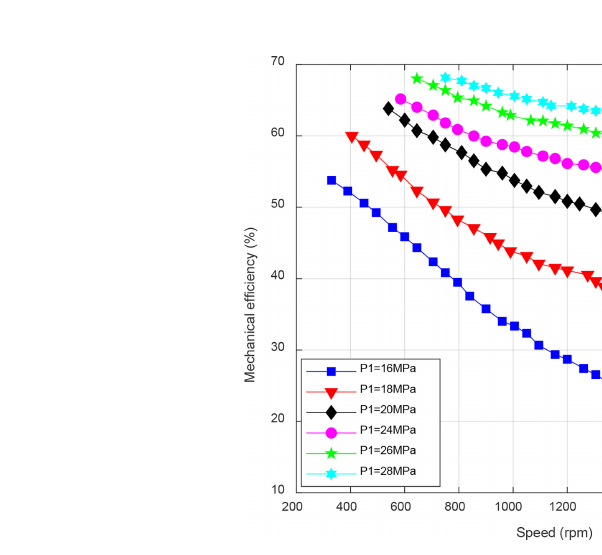
FIGURE 6 The mechanical ef fi ciency of hydraulic motor in the energy conversion